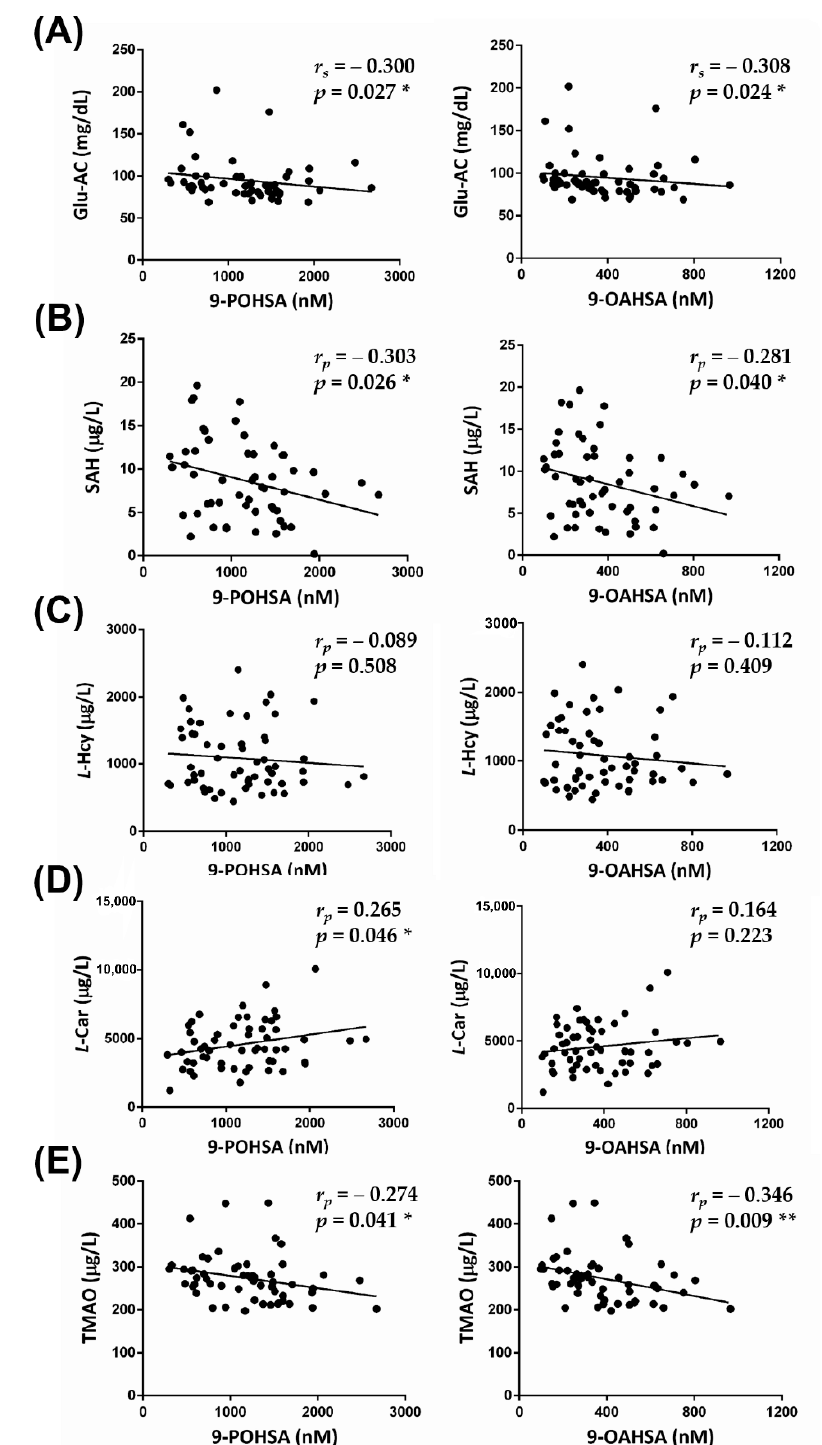
Figure 4. The correlation of FAHFAs with non-traditional CV-related biomarkers. 9-POHSA and 9-OAHSA had a significant negative correlation with Glu-AC ( A ) and SAH ( B ), but not with l -Hcy ( C ). L -Car was also positively correlated with 9-POHSA ( D ). TMAO had a significant negative correlation with both 9-POHSA and 9-OAHSA ( E ). r s : Spearman correlation coefficient, r p : Pearson correlation coefficient. Data are presented as mean ± SD (* p < 0.05, ** p < 0.01).